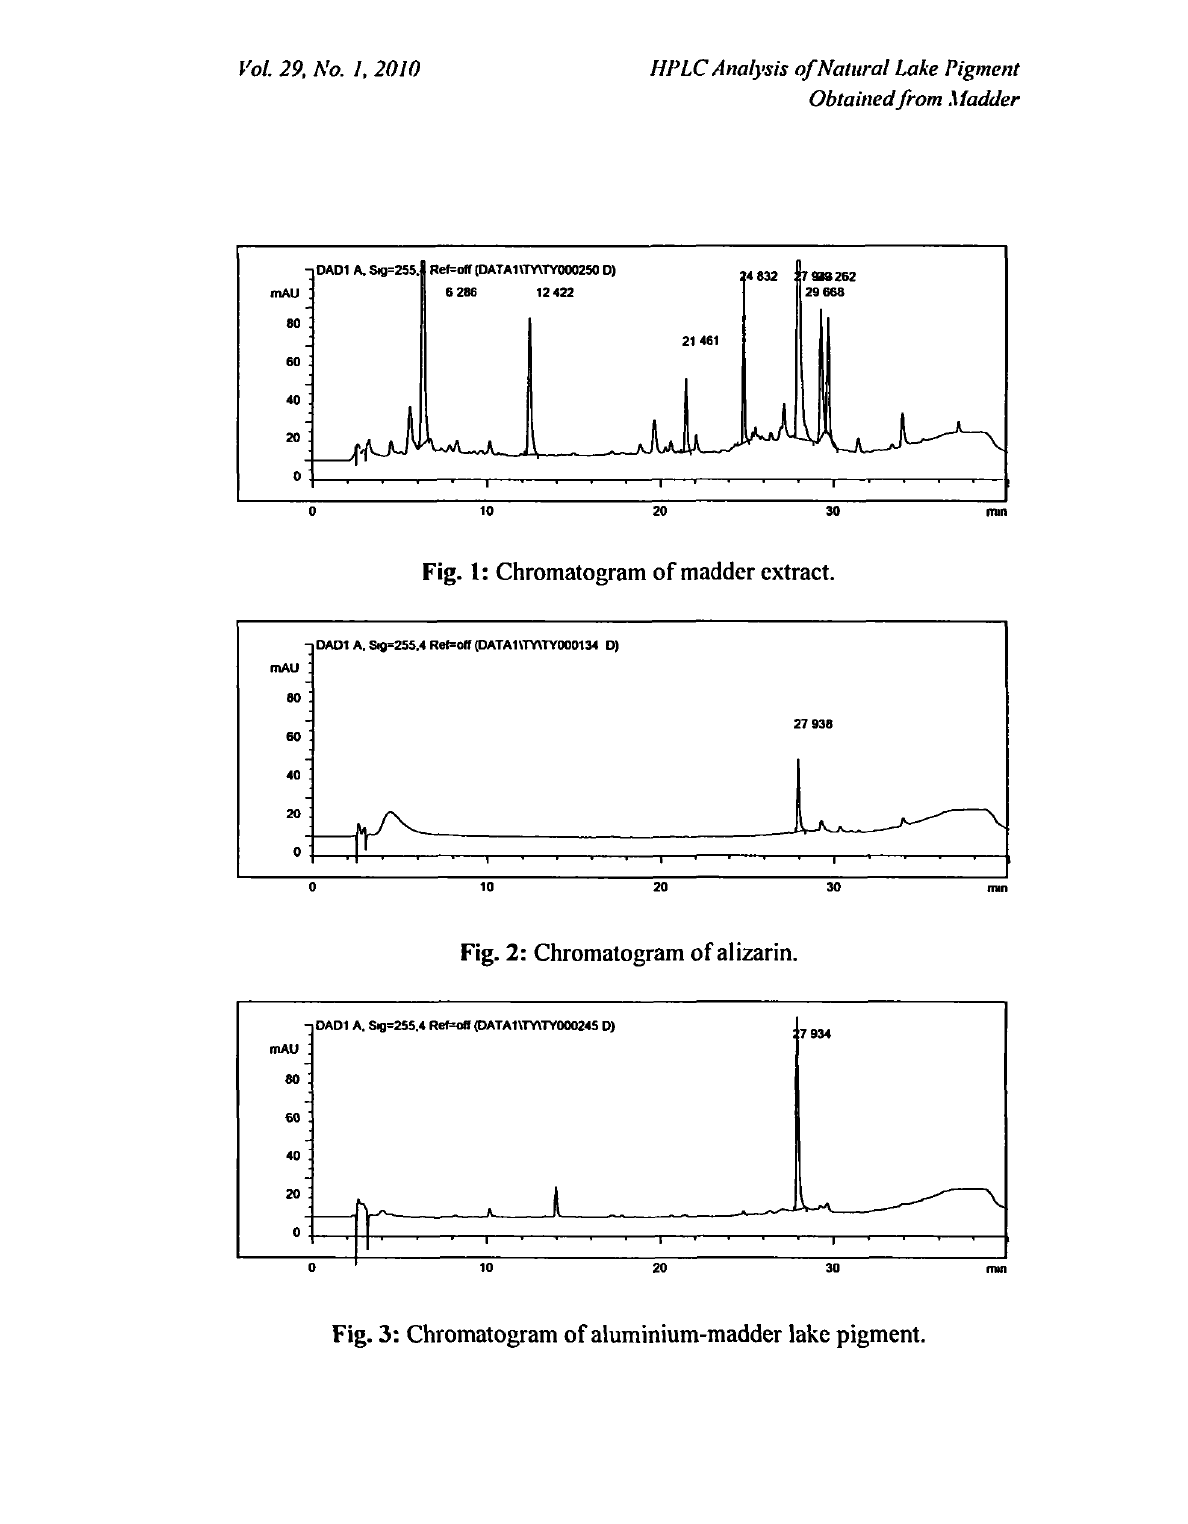
Fig. 3: Chromatogram of aluminium-madder lake